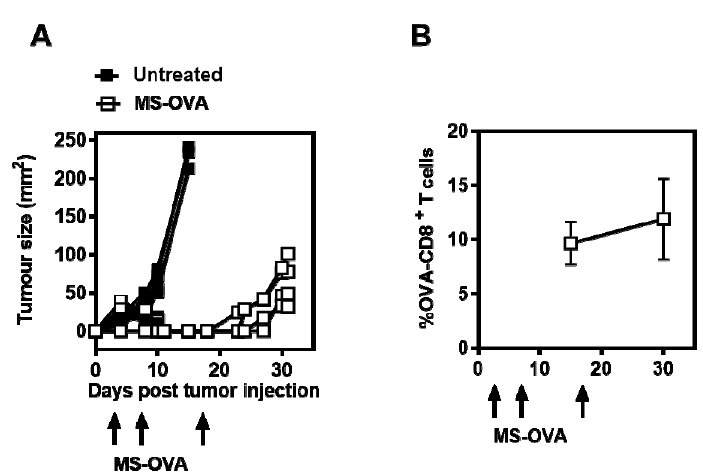
Figure 1. Therapeutic treatment of subcutaneous B16-ovalbumin (B-16-OVA) melanoma with Methanobrevibacter smithii -OVA (MS-OVA). C57BL/6 mice were given 10 6 B16-OVA melanoma tumor cells subcutaneously (s.c.) in the dorsal flank. On days 4, 8, and 18 after tumor injection, 20 µ g MS-OVA was injected s.c. at the base of the tail away from the tumor site. ( A ): Tumor growth in individual mice is shown for vaccinated mice and non-vaccinated mice; ( B ): The mean frequency ± SD of OVA-CD8 + T cells is shown at two time points for vaccinated mice ( n = 4/group). This was repeated twice.